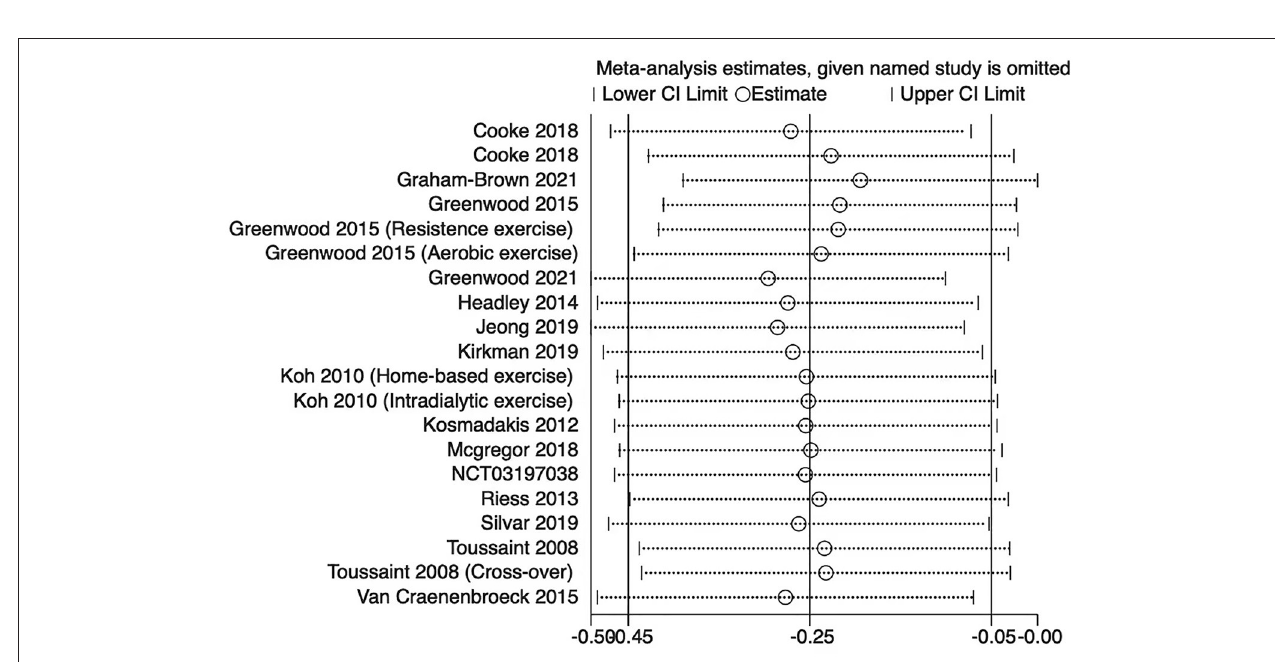
FIGURE 6 | Leave-one-out forest plot for the